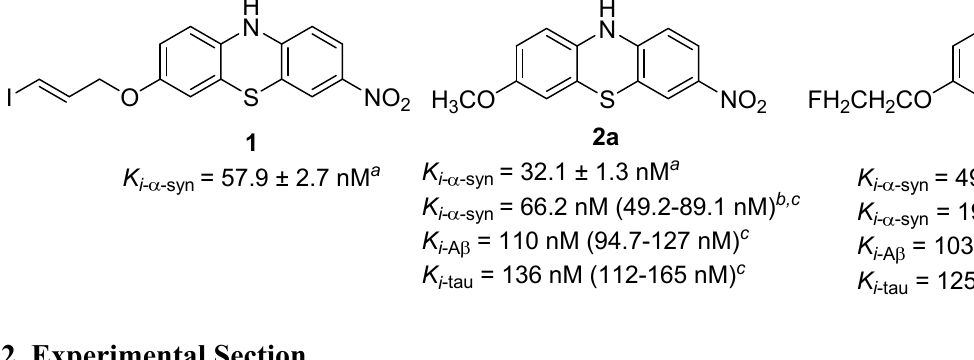
Figure 1. Potent tricyclic aromatic ring analogues. a Thioflavin T fluorescence assay; b 125 I competitive binding assay; c 95% confidence intervals for K in